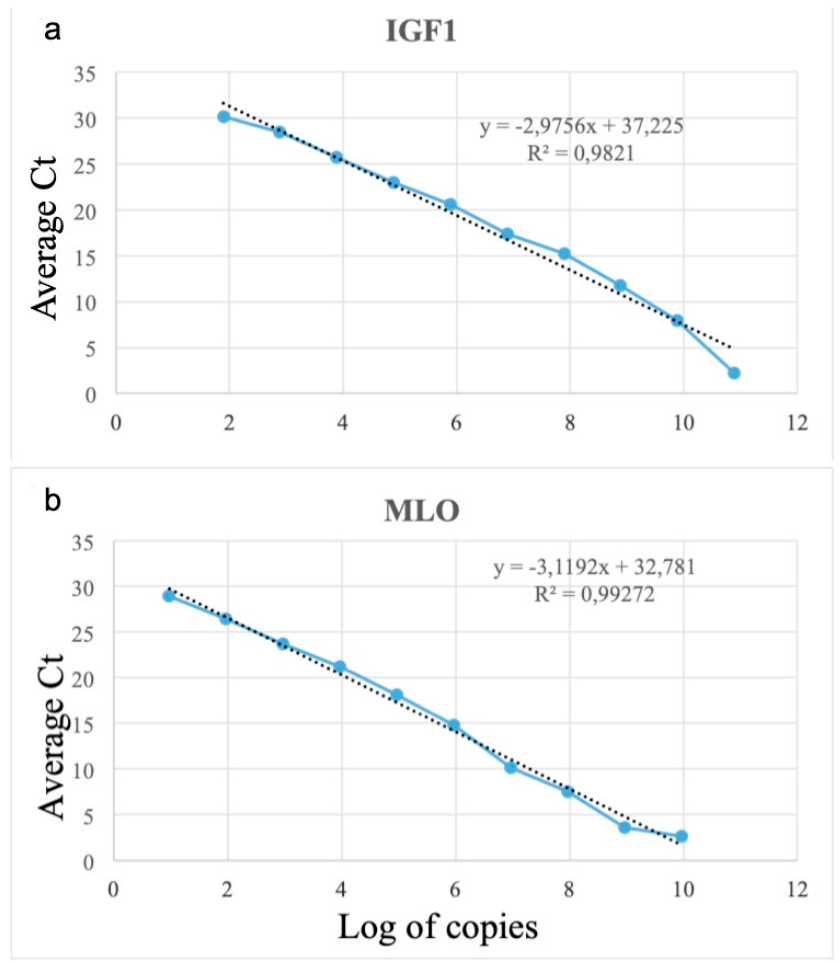
Figure 2. ( a , b ) : ( a ) Standard curve of SYBR, green-based RT-qPCR ampli fi cation of plasmid containing IGF segment and Midichloriaceae-like organism ( a ) Standard curve, was plo tt ed between mean Ct values obtained from each dilution of standard plasmid IGF against calculated log copy number (slope = 2.9756, R2 = 0.9821). ( b ) Standard plasmid with MLO fragment against estimated log copy number (slope = 3.1192, R2 = 0.9927).